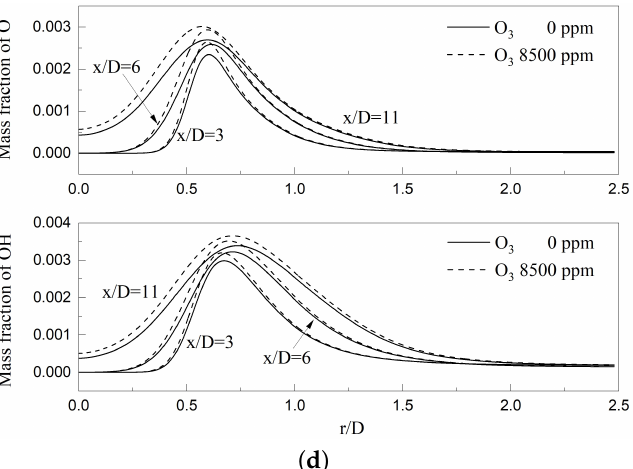
Figure 5. The time-averaged velocity, temperature, fuel, product, and intermediate product OH and O radical mass fraction distribution on r / D = 3, 6, 11. ( a ) the time-averaged velocity and temperature, ( b ) mass fraction of H 2 and CO, ( c ) mass fraction of H 2 O and CO 2 , and ( d ) mass fraction of O and OH. Table 2. The mean mass fraction of CO 2 of different radial positions at x / D = 11. r / D